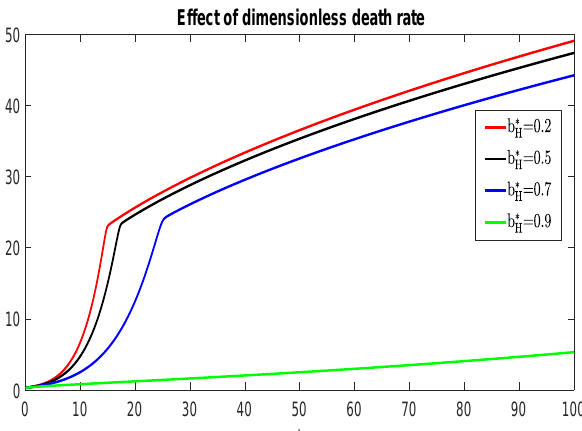
Figure 8. Effect of b ∗ on the dynamics of the model for fractional order 0.9 and fractal dimension H